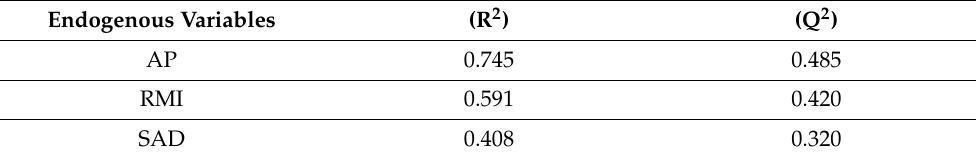
Table 4. Model goodness-of-fit R 2 and Q 2 values.